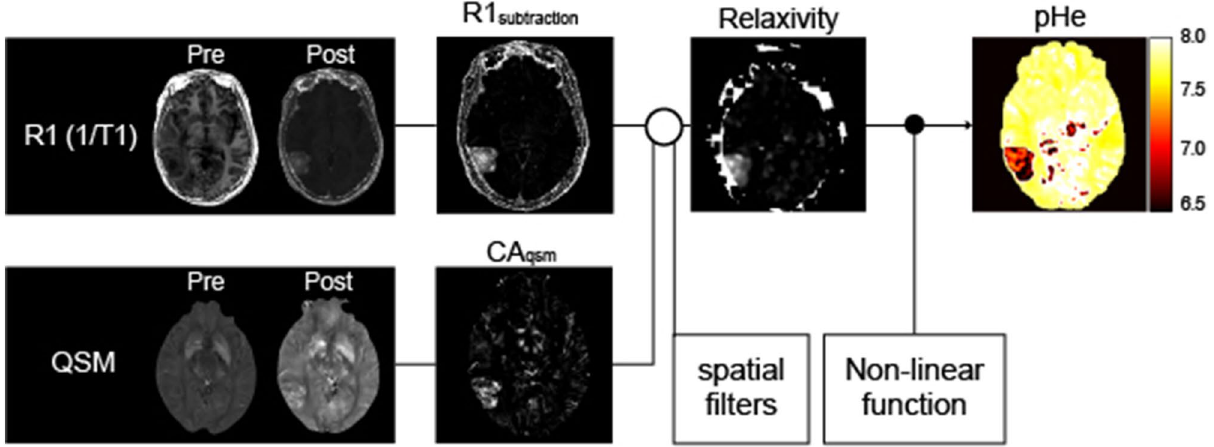
Figure 1. Scheme of the procedure for extracellular pH (pHe) calculation. Relaxivity (r1) and susceptibility maps were calculated from both quantitative parameter mapping (QPM) datasets before and after contrast agent (CA) injection. The subtraction ( R 1substraction ) map and the CA concentration map (CA qsm ) were then calculated from these R1 and susceptibility maps, respectively (see Eqs. 4 and 5). The relaxivity map was calculated by dividing the R 1substraction by CA qsm each voxel. The pHe was finally estimated by applying a pH calibration curve at body temperature (37